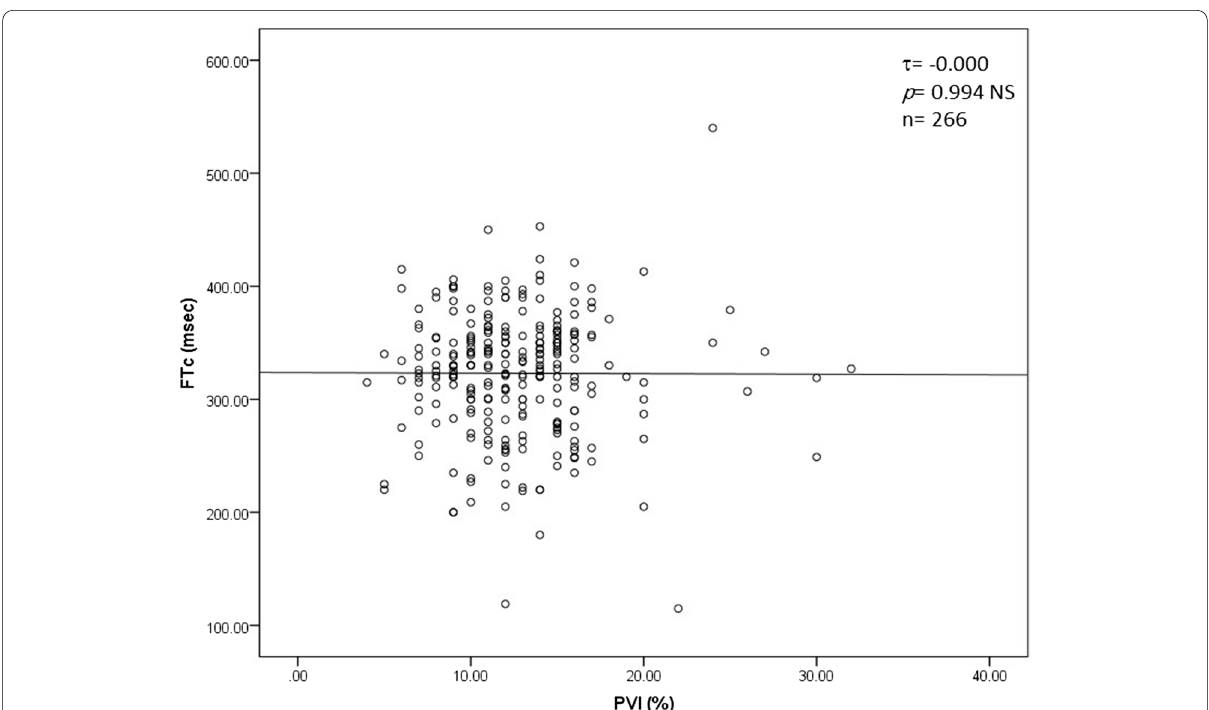
Fig. 2 Simple scatter plot with regression (best fit) line and correlation between transesophageal Doppler corrected flow time (FTc, msec) and pleth variability index (PVI,